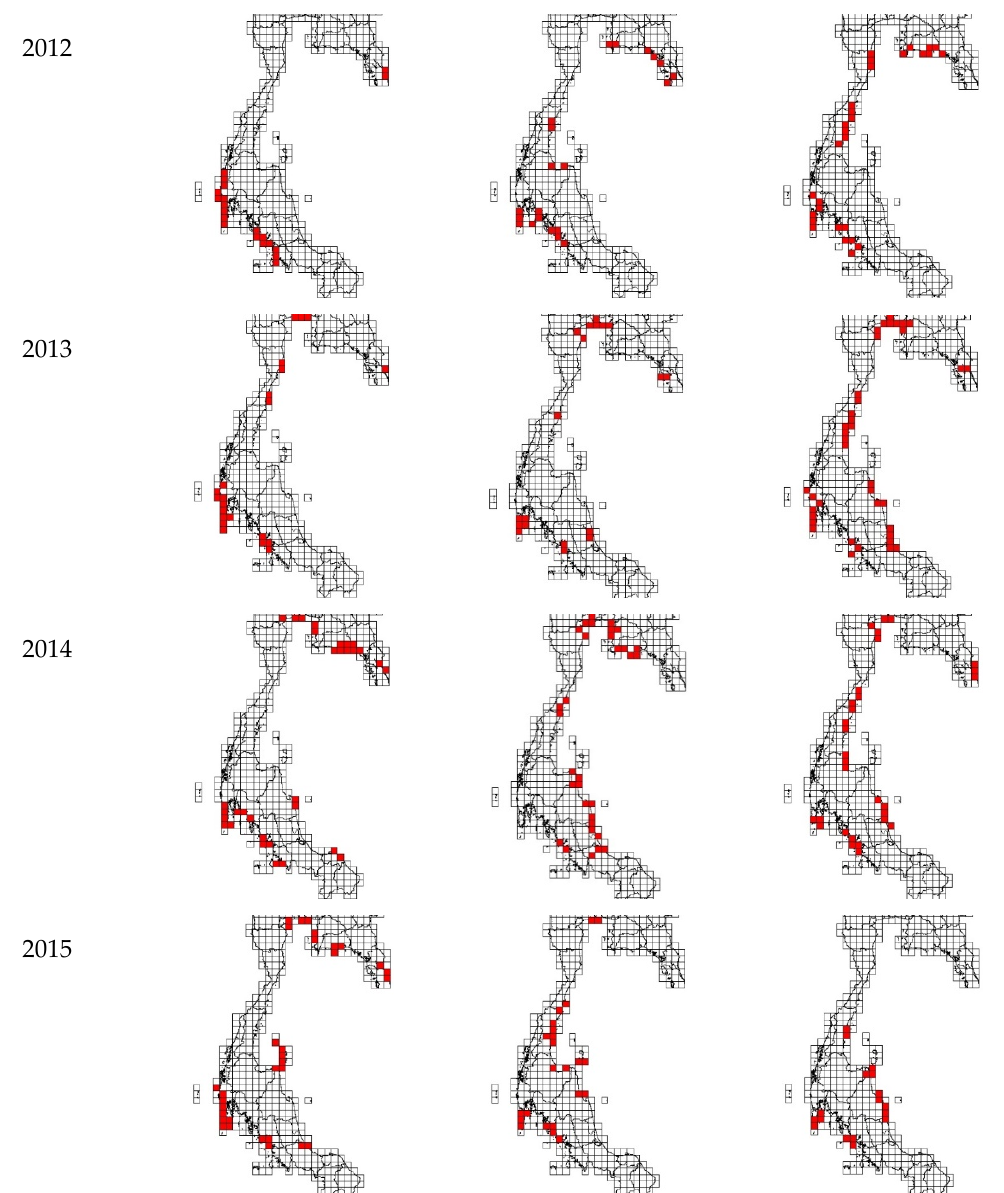
Figure 2. Spatial and temporal clustering of endangered marine species stranded from 2006 to 2015. The red square symbol indicates significant hotspot locations using the Anselin Local Moran’s I ( p < 0.01).